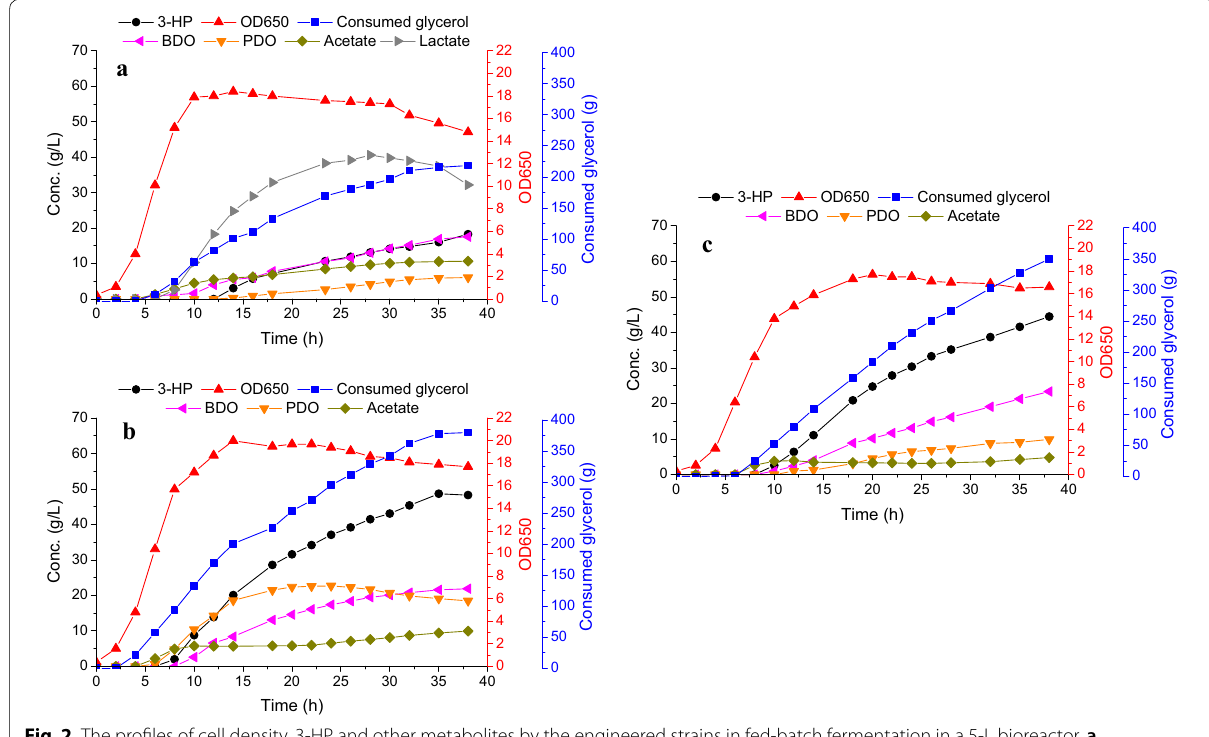
Fig. 2 The profiles of cell density, 3-HP and other metabolites by the engineered strains in fed-batch fermentation in a 5-L bioreactor. a Kp4(pUC18- kan - aldH ); b JJQ01(pUC18- kan - aldH ); c JJQ02(pUC18- kan - aldH ). OD 650 (back up-pointing triangle); 3-HP (black circle); PDO: 1,3-propanediol (back down-pointing triangle); BDO: 2,3-butanediol (back left-pointing triangle); acetate (black diamond); lactate (back right-pointing